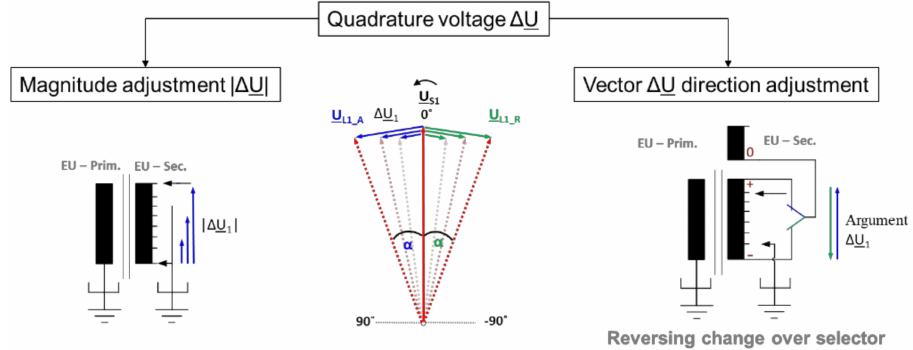
Figure 4. Quadrature voltage adjustment.